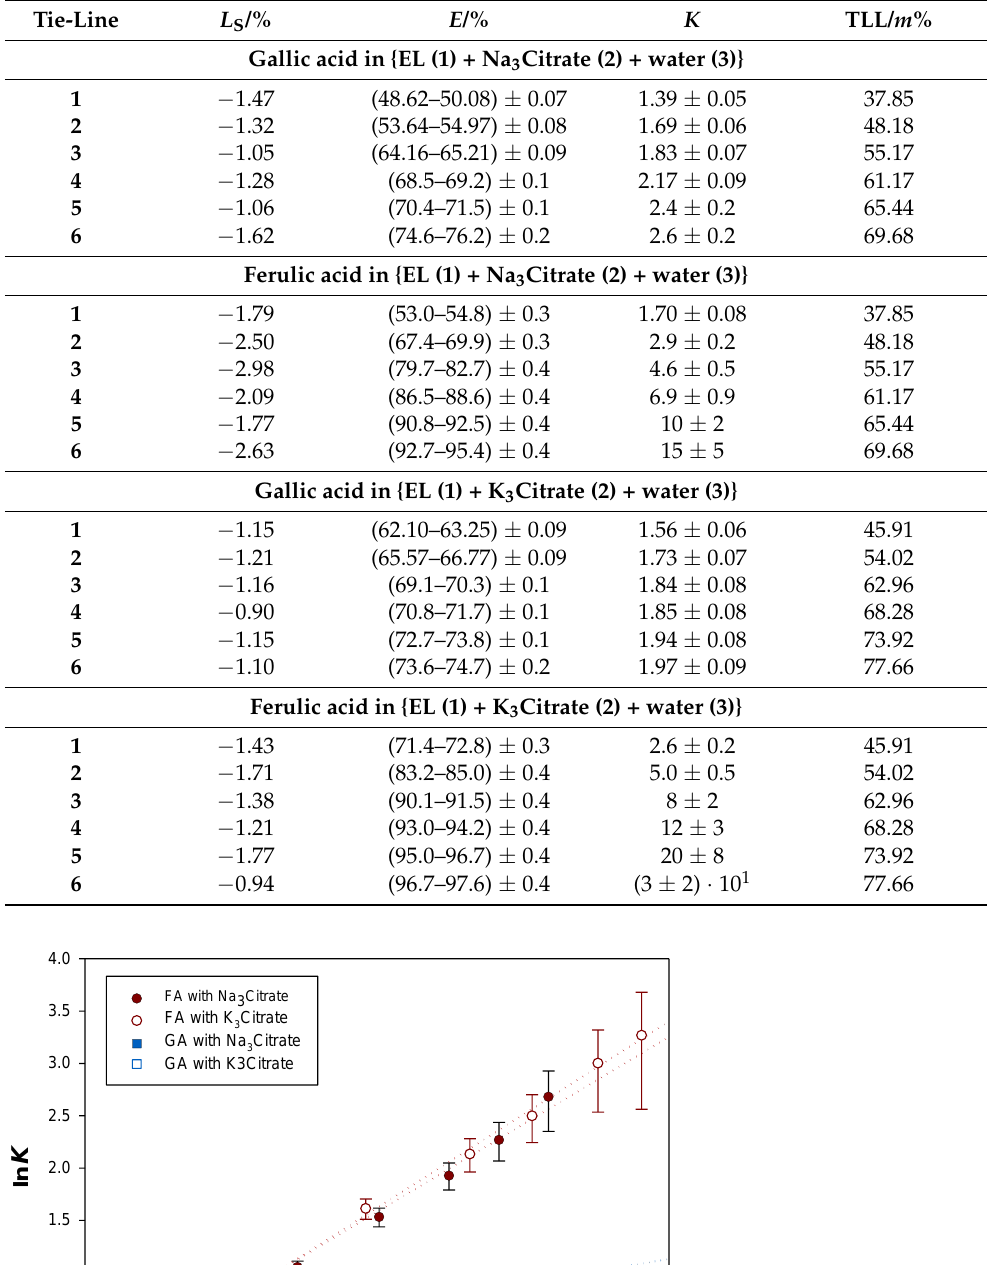
Table 5. Calculated solute losses ( L S ), extraction efficiency ( E ) intervals, partition coefficients ( K ) and literature-based tie-line lengths (TLL) for the extraction of gallic acid and ferulic acid in the ATPS